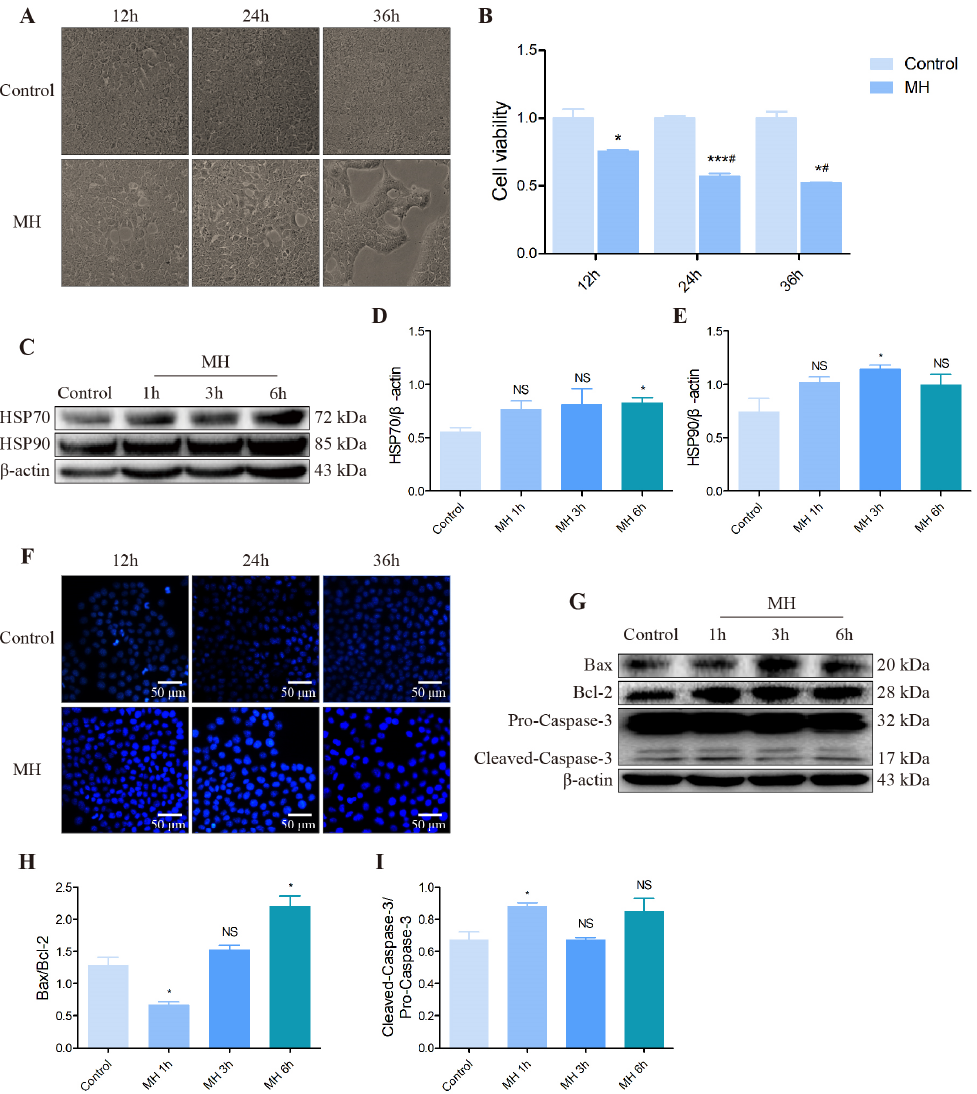
Figure 5. Effect of MH treatment on the cell morphology, number, HSPs and apoptosis-related protein expression in the AML12 cells. ( A ) The morphology of AML12 cells of control and cold groups. were observed under a microscope. (Scale bar = 50 µ m). ( B ) MTT assay was used to detect the effect of MH on the growth and proliferation of AML12 cells. ( C ) The protein level of HSP70, HSP90 and β -actin in each group. ( D , E ) Quantification of expression levels based on expression ratios of HSP70/ β -actin and HSP90/ β -actin. ( F ) Hoechst 33258 staining was used to detect the effect of MH on AML12 cell apoptosis. (Scale bar = 50 µ m). ( G ) The protein level of Bax, Bcl-2, Caspase-3 and β -actin in each group. ( H , I ) Quantification of expression levels based on expression ratios of Bax/Bcl-2, Cleaved-Caspase-3/Pro-Caspase-3. Data are presented as mean ± standard ( n = 3). NS means not significant, * p < 0.05, *** p < 0.001, # p < 0.05. Where * represents comparison with the control group corresponding to their respective time, and # represents comparison with MH 12